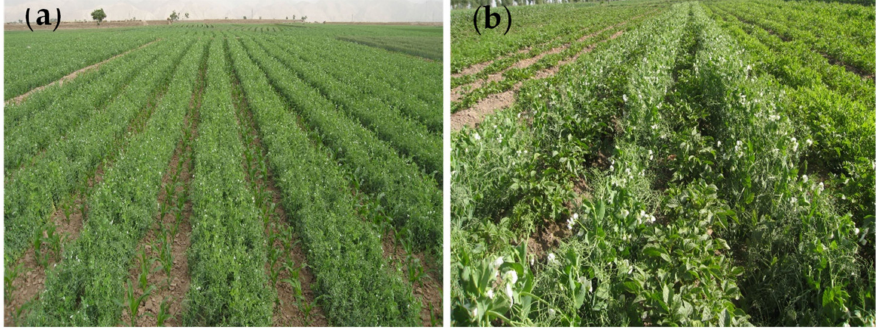
Figure 7. Intercropping patterns of Longwan No. 6 in Northern China; ( a ): maize-pea intercropping pattern; ( b ): potato-pea intercropping